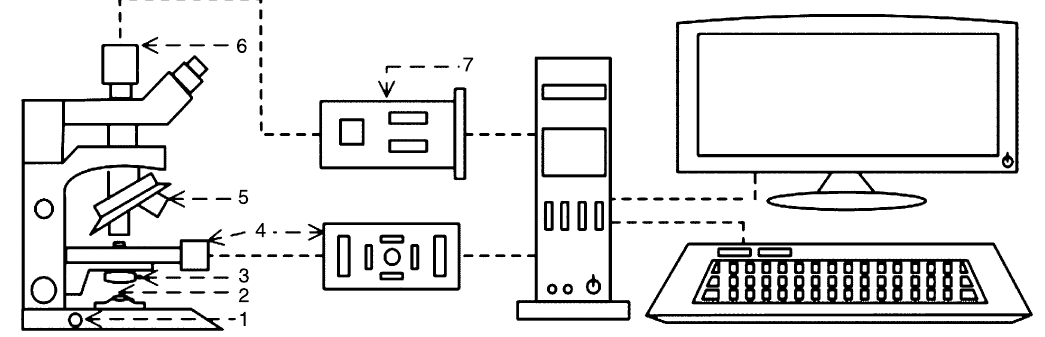
Fig. 1. Schematics of the prototype system configuration: 1-illumination intensity adjustment; 2-position for light intensity measurement; 3-condenser and its aperture diaphragm; 4-motorized microscope stage; 5-objectives; 6-CCD; 7-frame grabber.